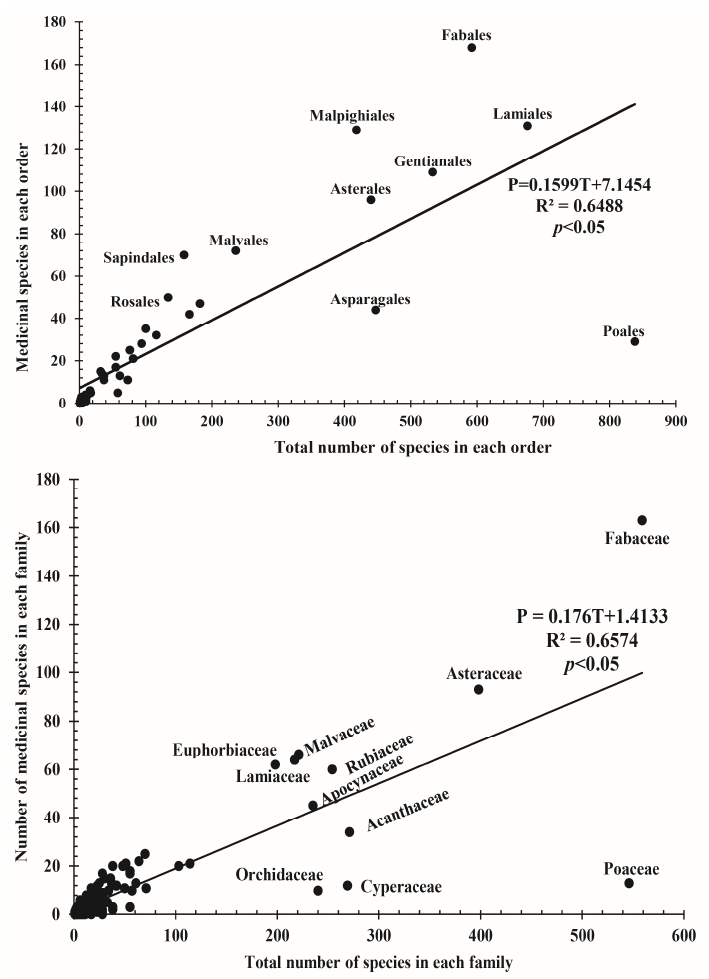
Figure 1. Linear regression model showing the relationship between the number of medicinal species and the total number of species for orders and families.